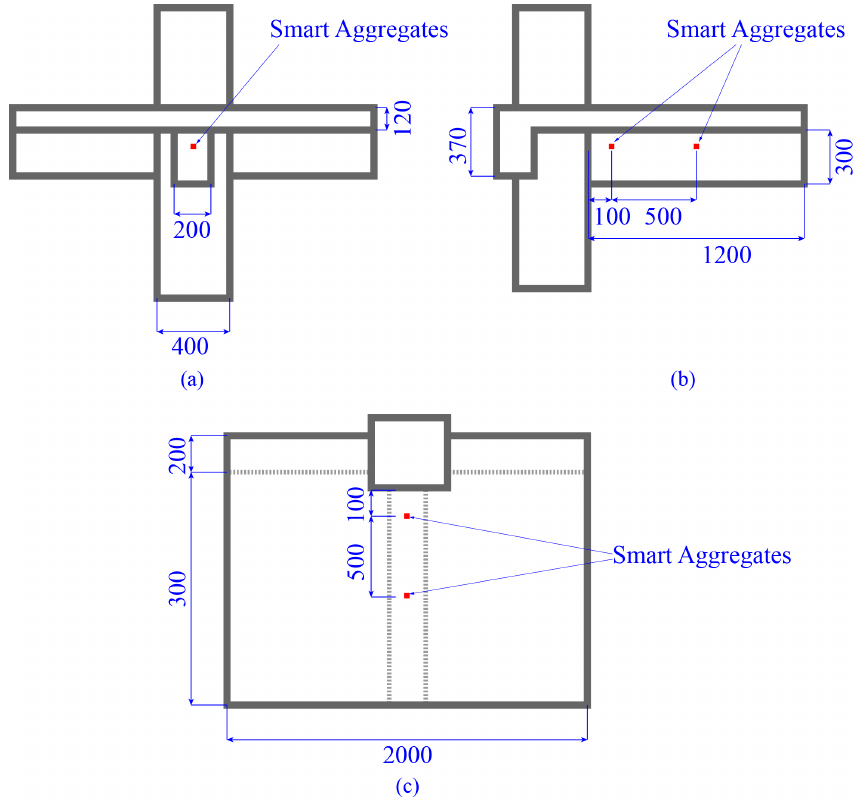
Figure 14. The size of the test specimen (unit: mm). ( a ) Front view; ( b ) Side view; ( c ) Top